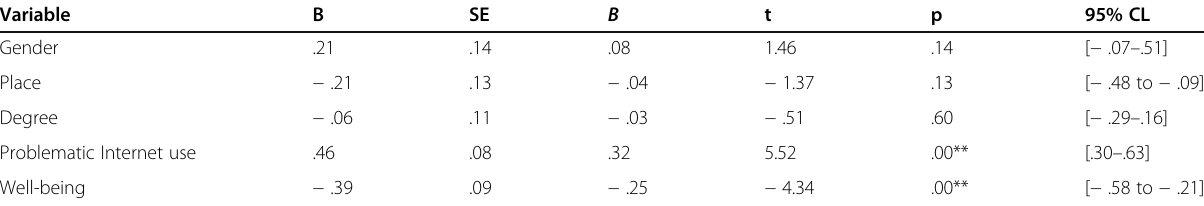
Table 3 Regression to predict eating disorder behaviors ( N = 566)